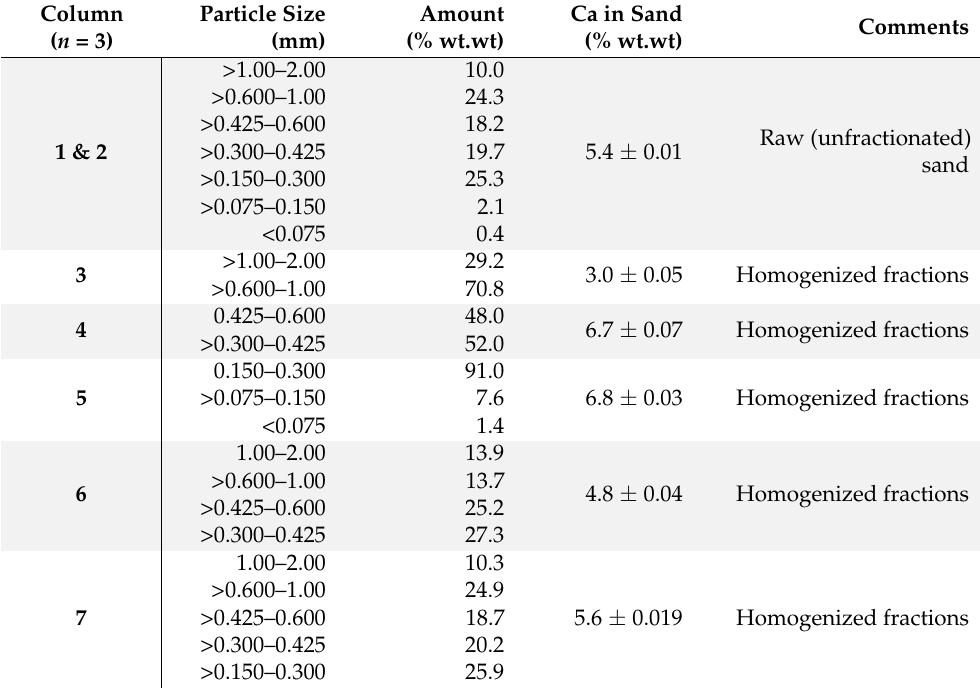
Table 1. Sand particle size fractions in columns (100 g per